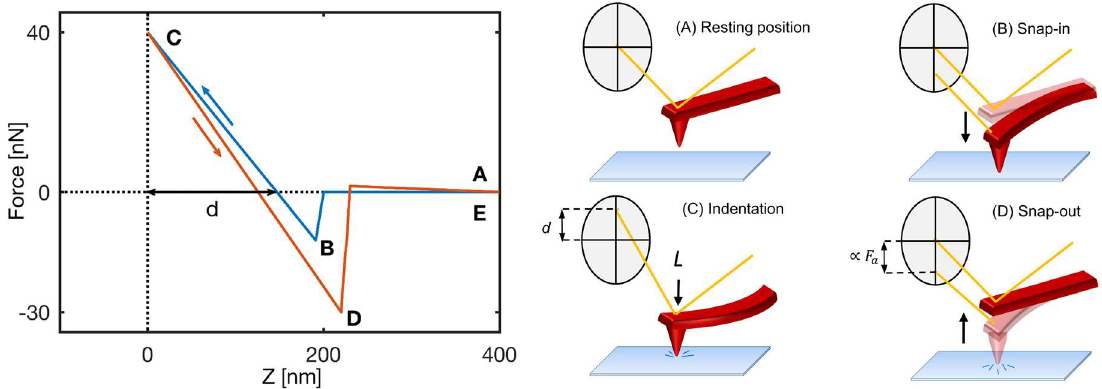
Figure 6. Hypothetical force-distance curve and its different regions: Resting position, snapping in (or jump-into-contact), indentation, and sapping out (or pull-off).